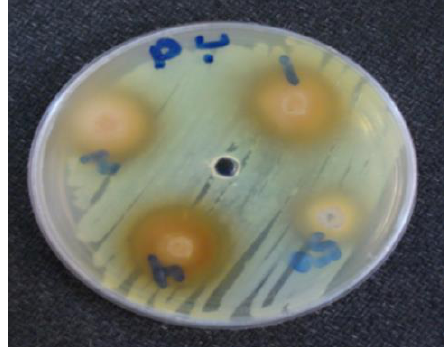
Figure, 5: Inhibition zones of Proteusspp. growth on Mueller-Hinton agar produced by ethanolic extract of Vitisvinifera , the peripheral four wells contained extract concentrations ( 50, 100, 200, 400 mg/ml) whereas the central well contained 0.1 ml of 96% ethanol